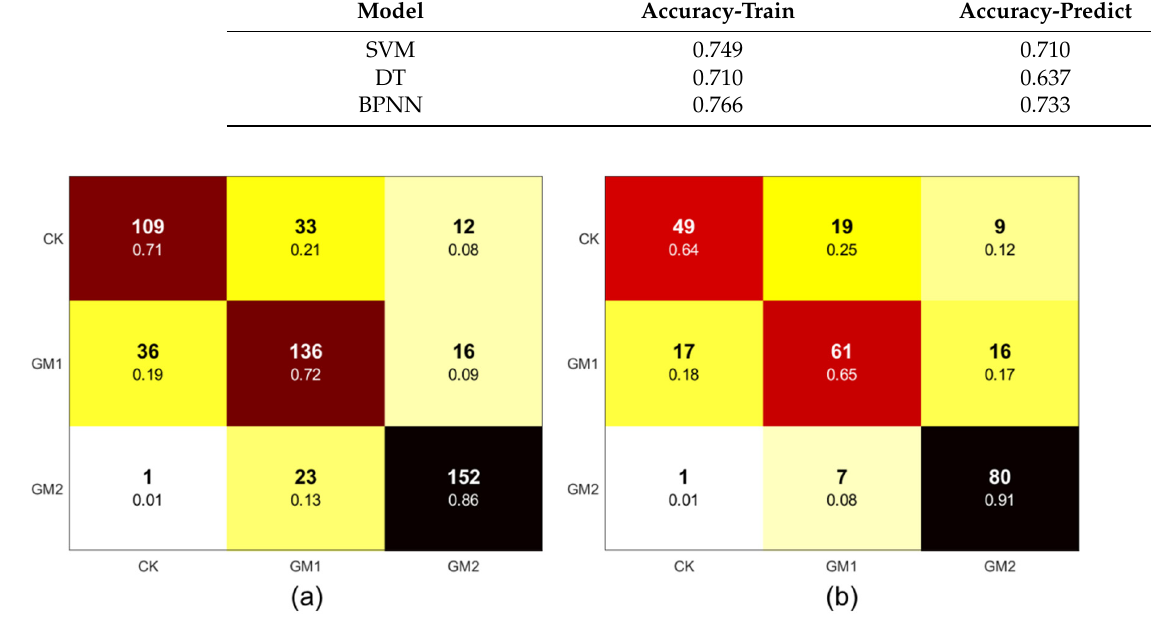
Figure 4. Confusion matrices of the training set ( a ) and the prediction set ( b ) for the BPNN model established by PCs.